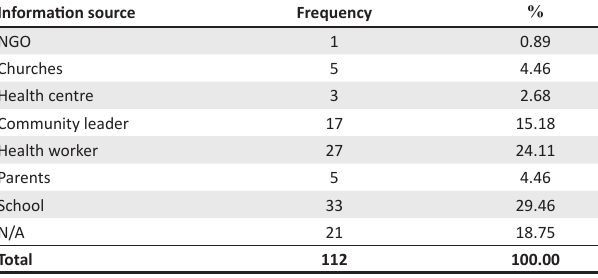
TABLE 1: Sources of information on rights of children with disability. Information